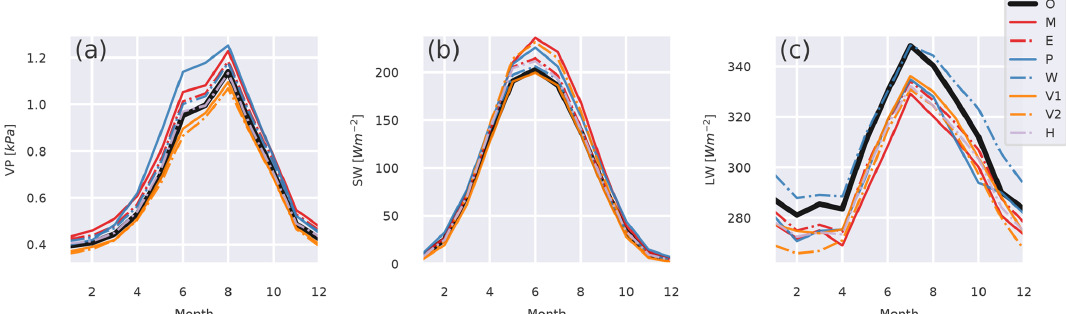
Figure 3. The seasonal cycles of monthly 2m vapor pressure (a) , incident shortwave radiation (b) , and incident longwave radiation (c) , averaged over the location observations are available. The month of the year is denoted on the horizontal axis. The observations (O) are plotted with a thick, continuous black line. MERRA2 (M, solid) and ERA-Interim (E, dashed) are plotted in red, PGMFDv2 (P, solid) and WFDEI (W, dashed) in blue, VFDv1 (V1, solid) and VFDv2 (V2, dashed) in orange, and HySN (H) with a dashed lilac line.